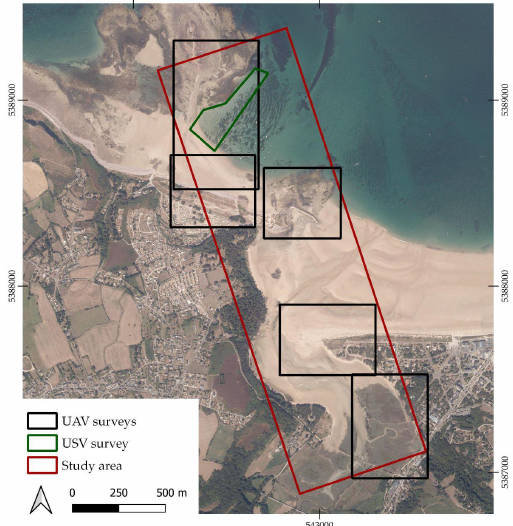
Figure 2. The area studied, and the location of the 6 ground-truth data acquisitions (WGS 84/UTM